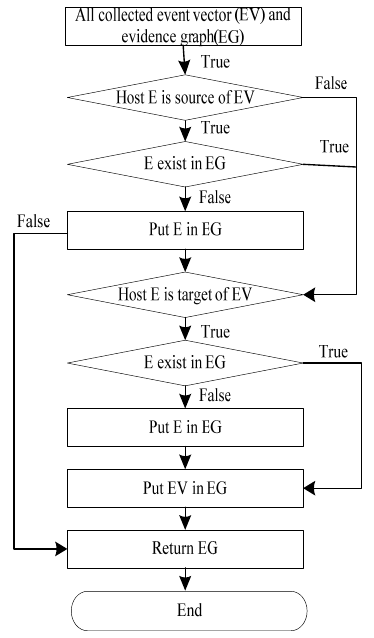
Figure 3. The Algorithm for Constructing an Evidence Graph.